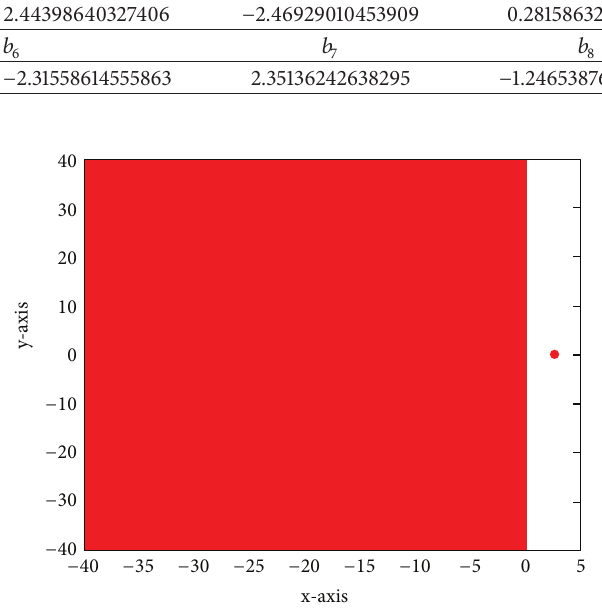
Figure 1: Stability region of the M968 method. Figure 2: Difference in dispersion. Methods used: (i)– ◻ –., in